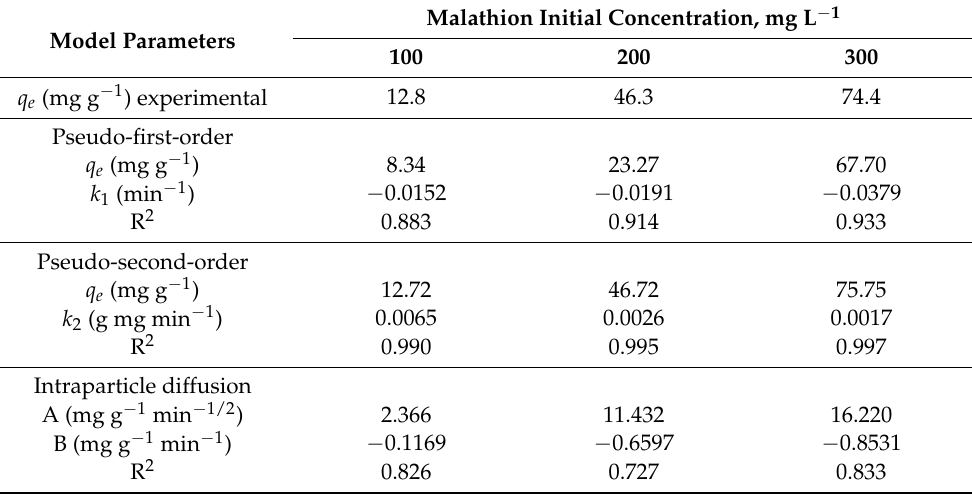
Table 1. Results of fitting parameters to experimental data of three kinetic models onto SG-LGPS. Model